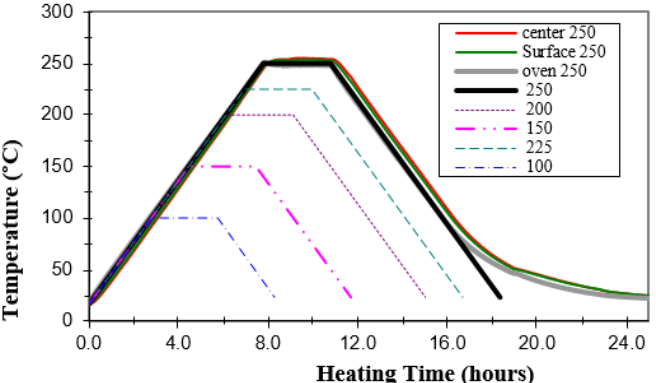
Figure 5. Real time-Experimental temperature records vs. heating time.